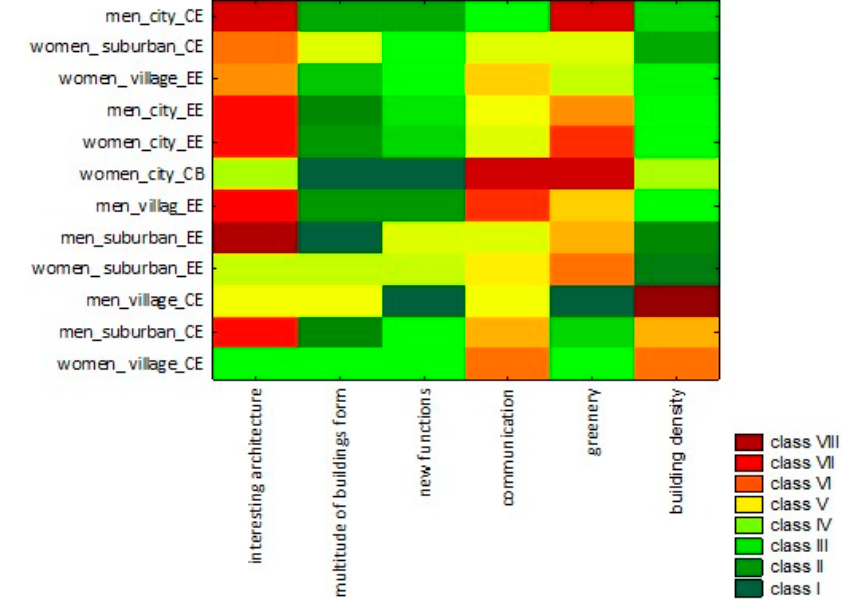
Figure 14. Perception of the urban landscape depending on the field of study, gender and place of residence (EnvEng and CivEng students combined, n = 244).